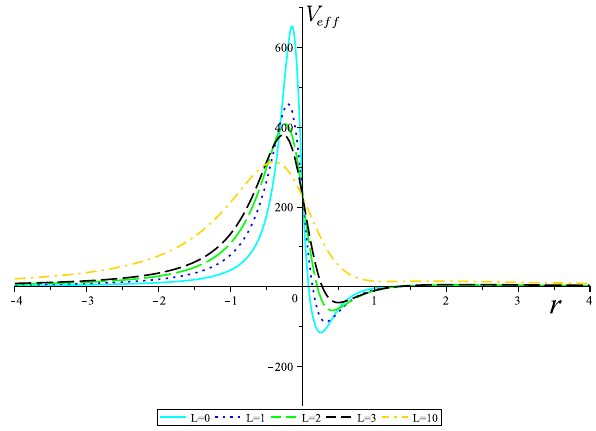
Fig. 1 Plots of V ef f versus r for the spin-0 particles. The physical parameters are chosen as; M = m = 1 ,ω = 15 , a = 0 . 3 , and λ = 2